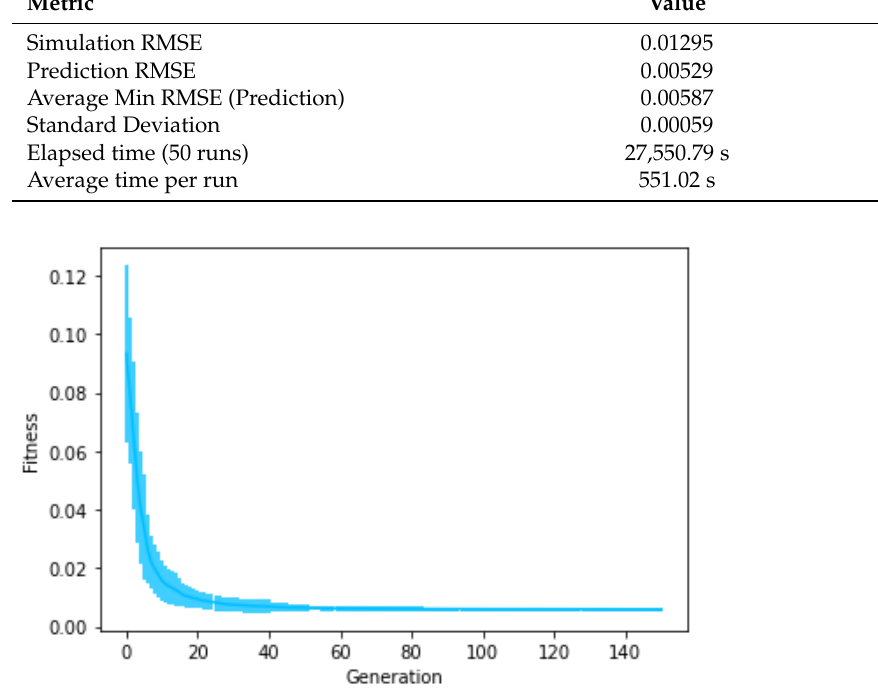
Figure 9. Average minimum fitness and error bars (prediction RMSE) for the Silverbox problem.